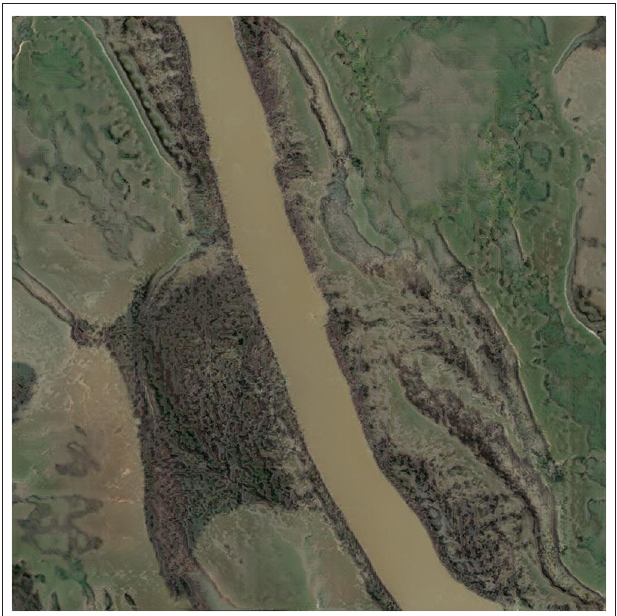
TABLE 3 | The Laplacian SWD scores for the network trained on Dataset B.